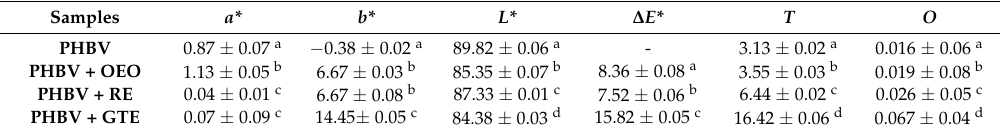
a * : red/green coordinates (+a red, − a green); b * : yellow/blue coordinates (+b yellow, − b blue); L * : Luminosity (+L luminous, − L dark); ∆ E *: color differences; T : transparency; O : opacity. a–d Different letters in the same column indicate a significant difference ( p <